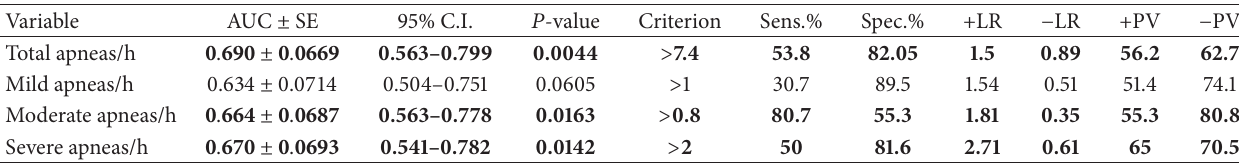
Table6:Frequency/severityofapneas,recordedduringeitherthewakefulnessorsleep,identifiesRettpatientswithincreasedintraerythrocyte non-protein-bound iron (IE-NPBI) levels: receiver operating characteristic (ROC) curves analyses.